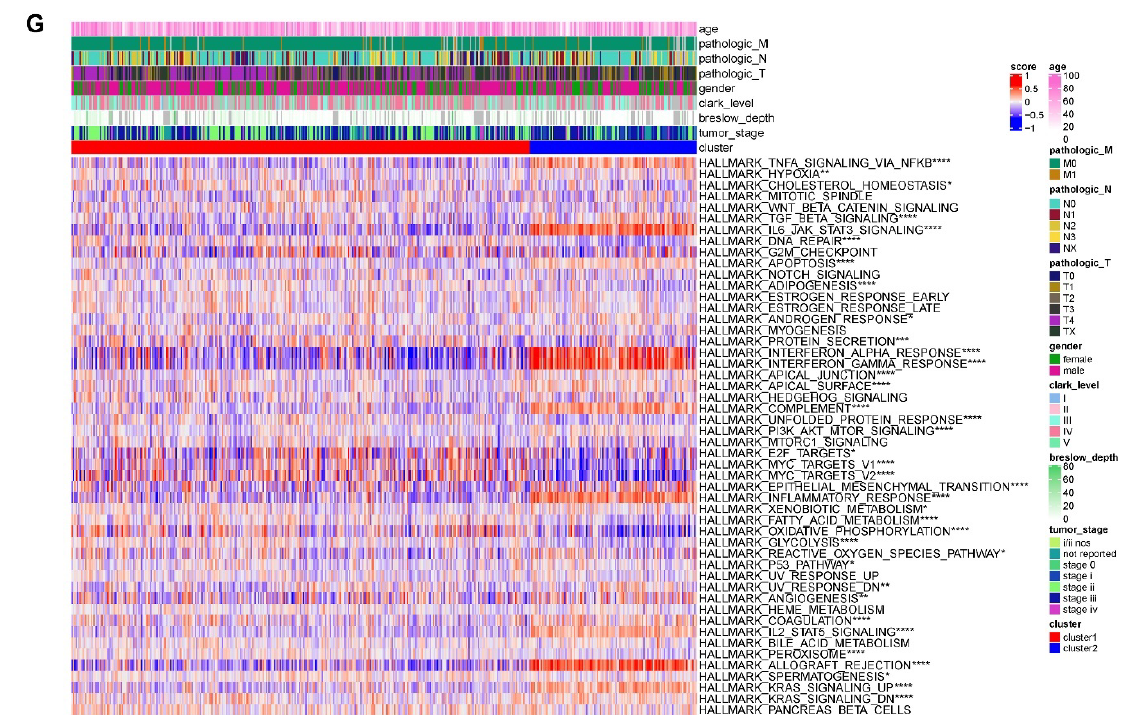
Figure 5. Different modes of phagocytosis regulation in tumors. ( A – F ) Identification of molecular subtypes of phagocytosis regulators. ( A ) Heat map of unsupervised clustering of samples. ( B ) Cumulative distribution graph. ( C ) Unsupervised clustering gravel map. ( D ) Inter-subtype Overall Survival (OS)-based Kaplan-Meier curves. ( E ) Principal component analysis (PCA) scatter plot. ( F ) Heat map of phagocytosis regulators expression. ( G ) Heat map display of enrichment analysis results of the inter-subtype hallmark pathway. We performed MSigDB database-based hallmark pathway enrichment analysis on samples between subtypes, with 37 of the 50 pathways showing significant differences (* p < 0.05, ** p < 0.01, *** p < 0.001, **** p < 0.0001).